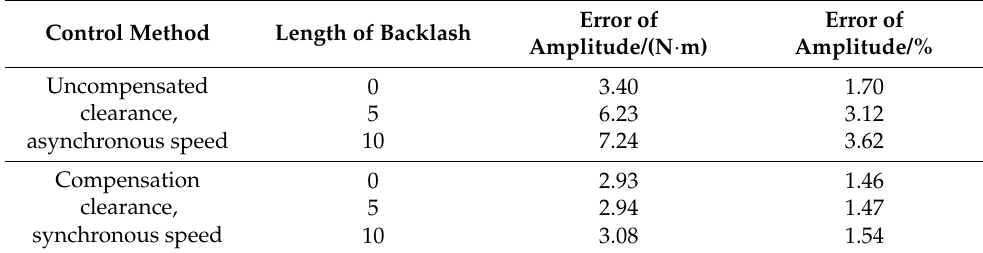
Table 3. Tracking error of clearance compensation.